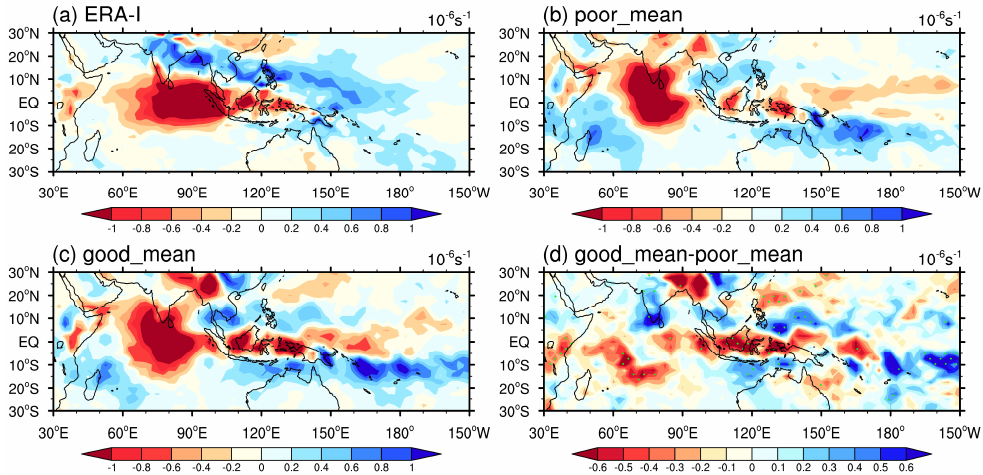
Figure 16. MJO-related boundary layer moisture convergence which is computed by regressing the vertically integrated (from surface to 700 hPa) moisture convergence against the area-averaged time series of 20–100 day filtered OLR in the reference area (5 ◦ S–5 ◦ N; 75 ◦ –85 ◦ E) in ( a ) observation, ( b ) composite of poor simulations, ( c ) composite of good simulations and ( d ) di ff erence between the composites of good and poor simulations where the di ff erences reaching 90% confidence level are